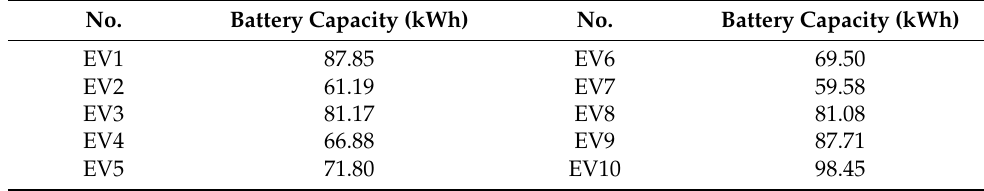
Table 5. Electric vehicle battery capacity